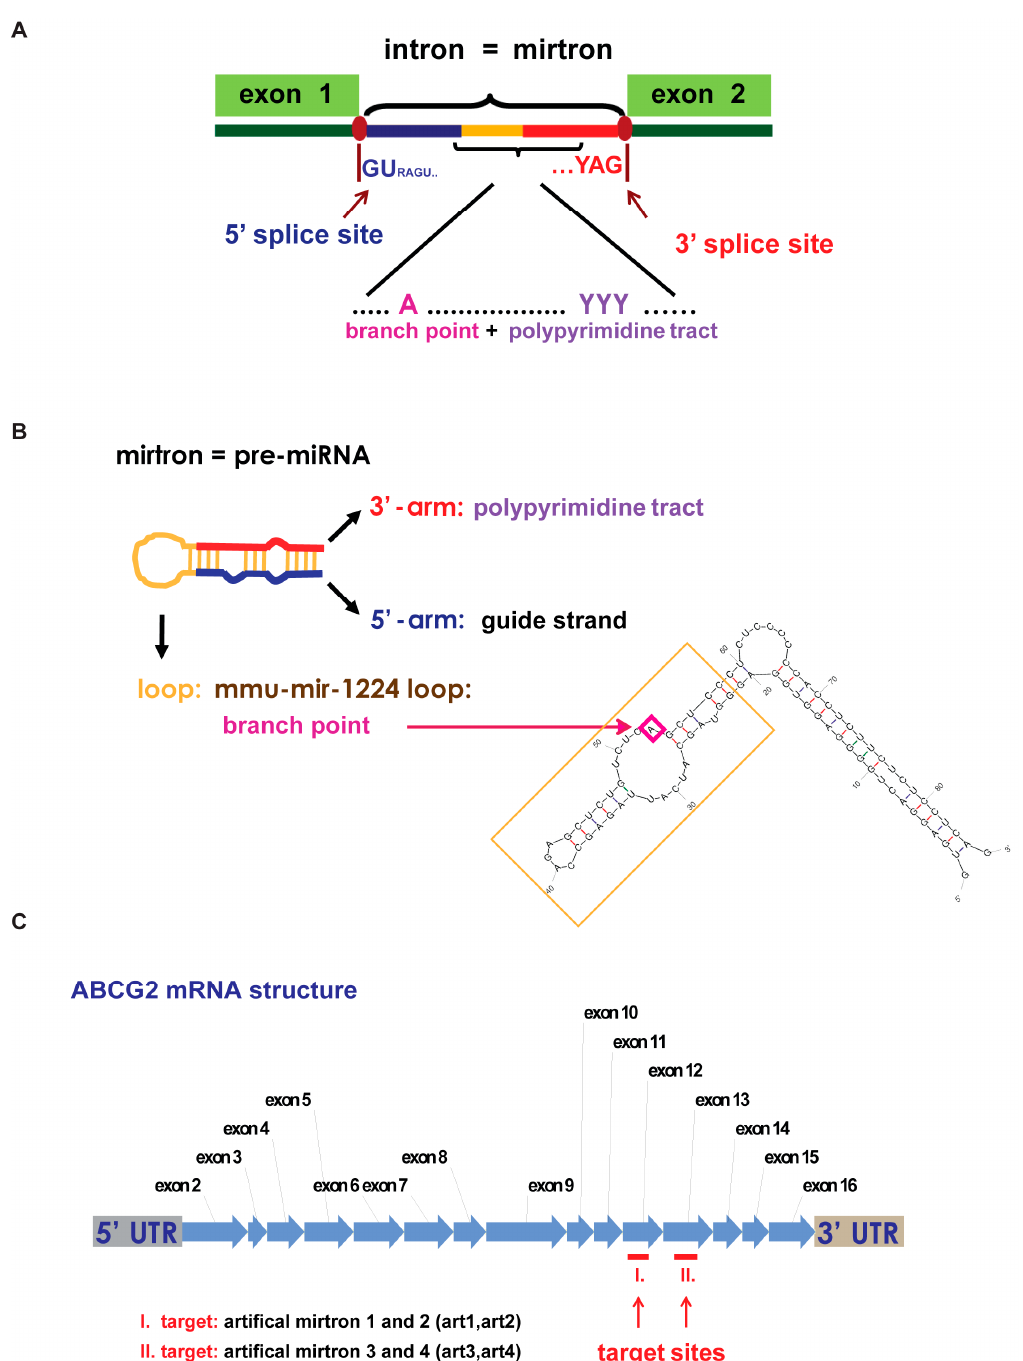
Figure 1. Artificial mirtron design. ( A ) A schematic representation of essential splicing criteria of introns in humans. Since mirtrons are small introns that are liberated by the splicing machinery instead of the Drosha/DGCR8 complex, their sequences should contain the indicated sequence motifs. ( B ) A demonstration of the artificial mirtron design. In the designed mirtronic pre-miRNAs, the 5 ′ -arm gives the potential small guide RNA, and the loop region is originated from Mus musculus mir-1224 loop region containing the branch point, while the 3 ′ -arm contains the polypyrimidine tract. The shown putative structure of the mmu-mir-1224 was predicted by the mFold program. ( C ) A schematic representation of the mRNA of ABCG2 membrane transporter protein. Target sites are shown by red, while the experimentally investigated targeting artificial mirtrons (arts) are also indicated.